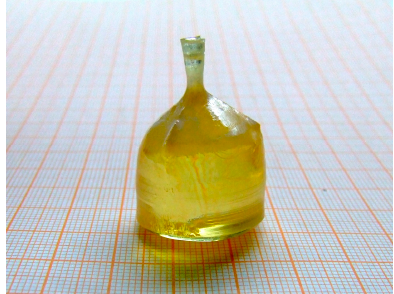
Figure 1. Photograph of the as-grown Mg: 7 LiNbO 3 crystal.